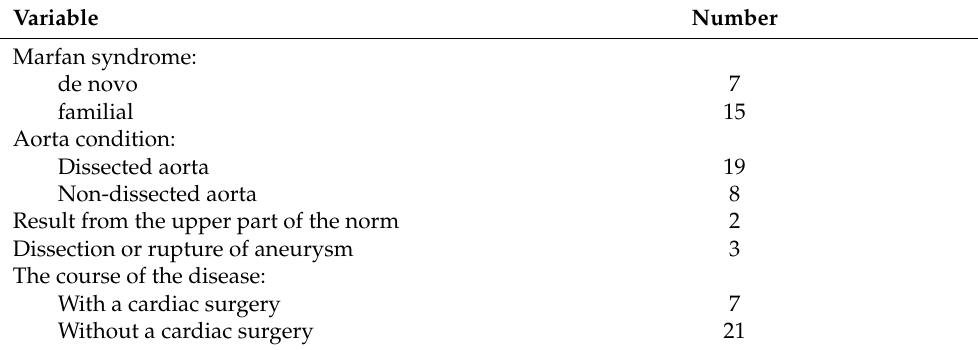
Table 2. Clinical data concerning people with Marfan